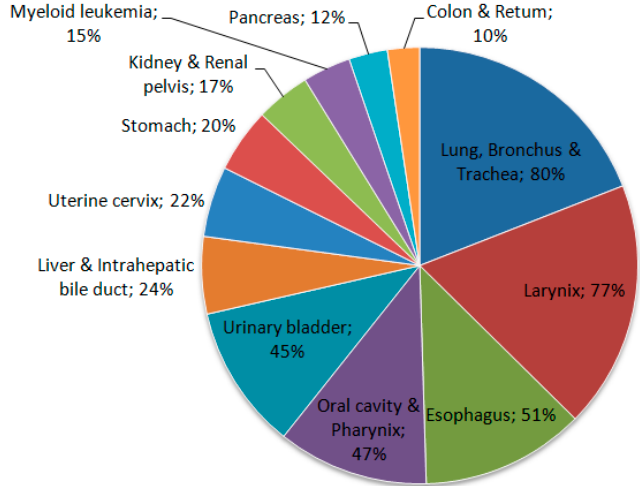
Figure 2. Proportion of cancer deaths attributable to smoking in adults aged 35 years and over, USA, 2011. Source: Adapted from Siegel et al. 2015 [28].